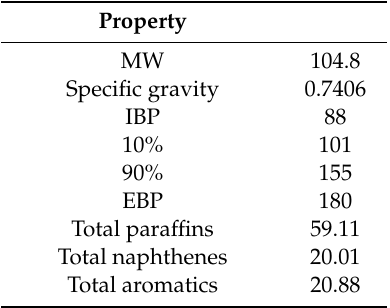
Table 5. Feed stock Properties of Commercial Catalytic Reformer